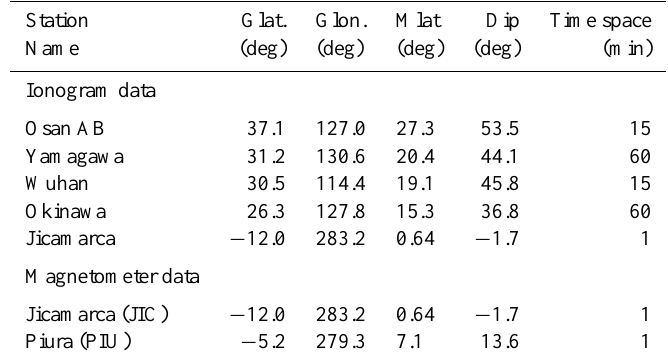
Table 1. Information about stations from which ionogram and magnetmeter data were collected in this storm study. Station Glat. Glon. Mlat Dip Time space Name (deg) (deg) (deg) (deg) (min) Ionogram data Osan AB 37.1 127.0